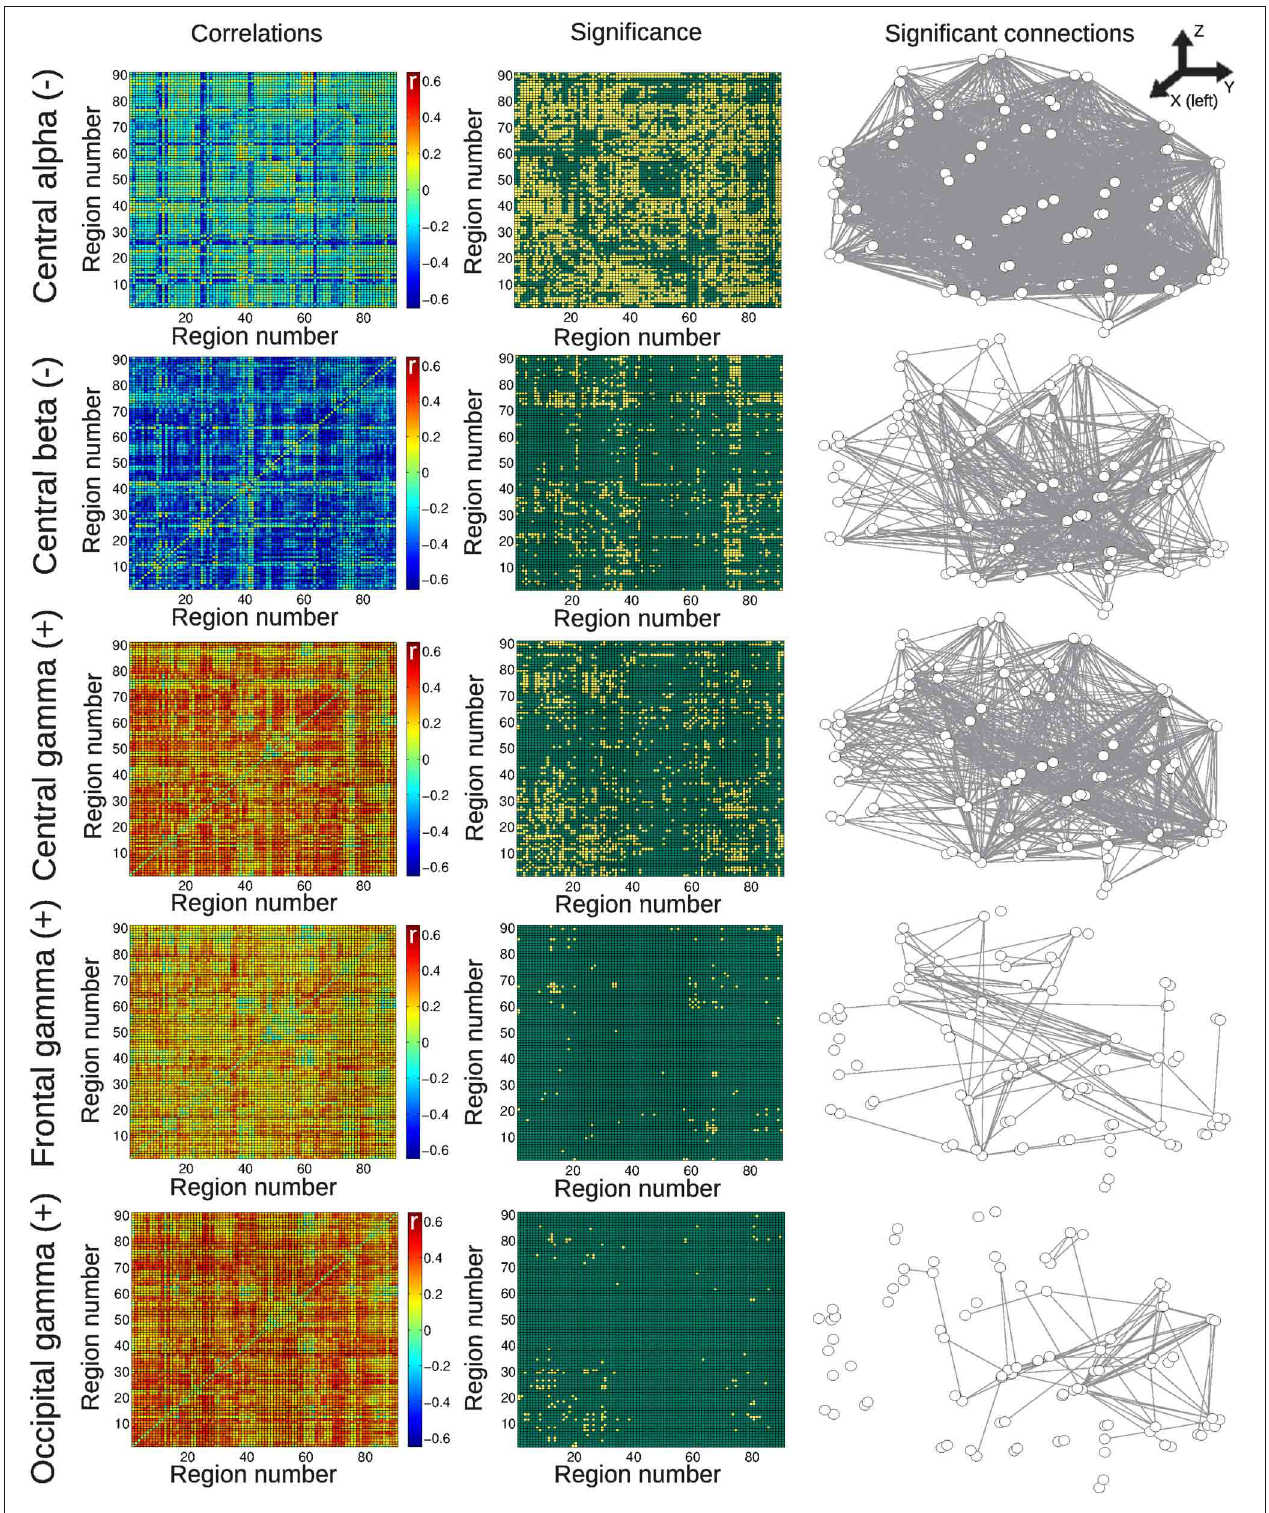
FIGURE 4 | Matrices of average correlation (left), significant correlations (center, significant correlations in yellow), and networks in anatomical space (left: posterior side, right: anterior side) with links representing significant correlations (right). Correlations are between temporal changes